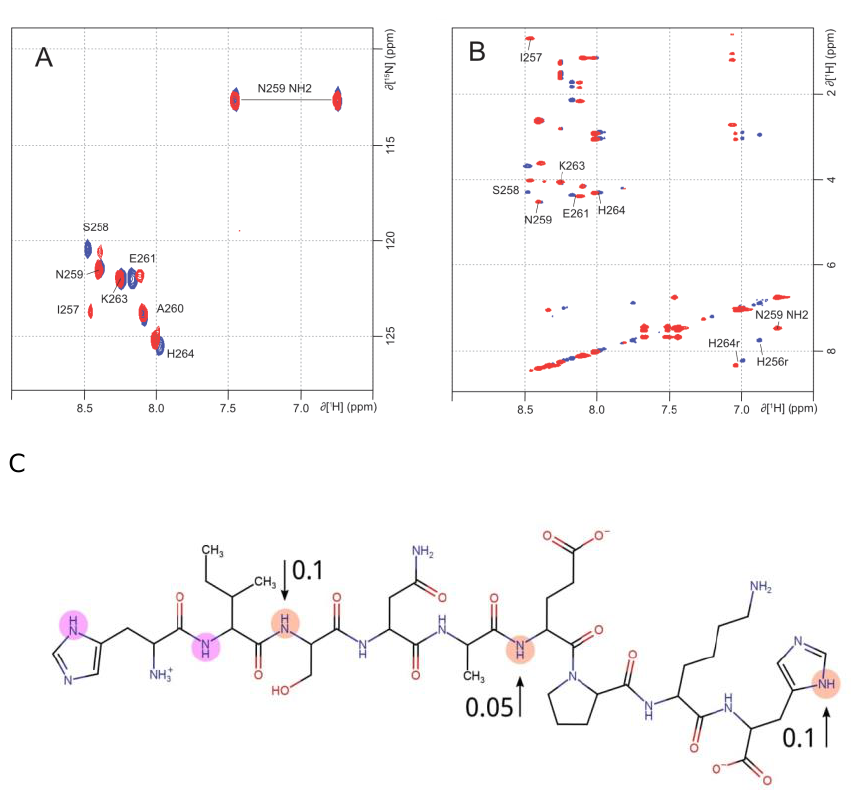
Figure 3. ( A ) 1H-15N HSQC spectra of ALR peptide (in blue) recorded at natural abundance for a sample at 0.8 mM concentration, 290 K and in phosphate buffer pH 6.8. For Zn 2+ /ALR complex (in red) the same conditions were used with a ratio of 10/1. NH group and Asn259 side chain NH2 assignments are indicated. ( B ) Zoom in on the homonuclear TOCSY spectra of free (in blue) and Zn 2+ bound (in red) ALR peptides. ( C ) Chemical structure of ALR peptide. Atoms highlighted with red circles correspond to atoms with chemical shift upon zinc binding greater than 0.05. Atoms highlighted with pink circles correspond to atoms with new peaks upon zinc binding. The NMR spectra were recorded on a Bruker 600 MHz (Billerica, MA, USA) equipped with a TCI cryoprobe at 290 K. ALR peptide was at 0.8 mM concentration in a 10 mM phosphate buffer at pH 6.8. The spectra of Zn 2+ /ALR complex were obtained at a ratio 10:1. Sequential assignments of NH groups and side-chain protons of the peptide are indicated using protein numbering.